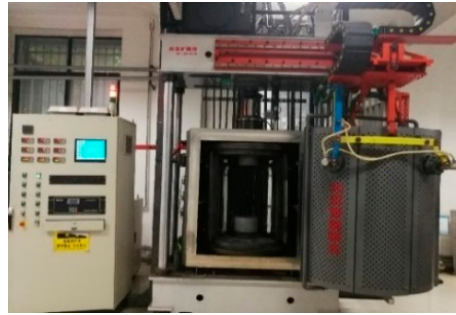
Figure 2. Vacuum diffusion bonding equipment.